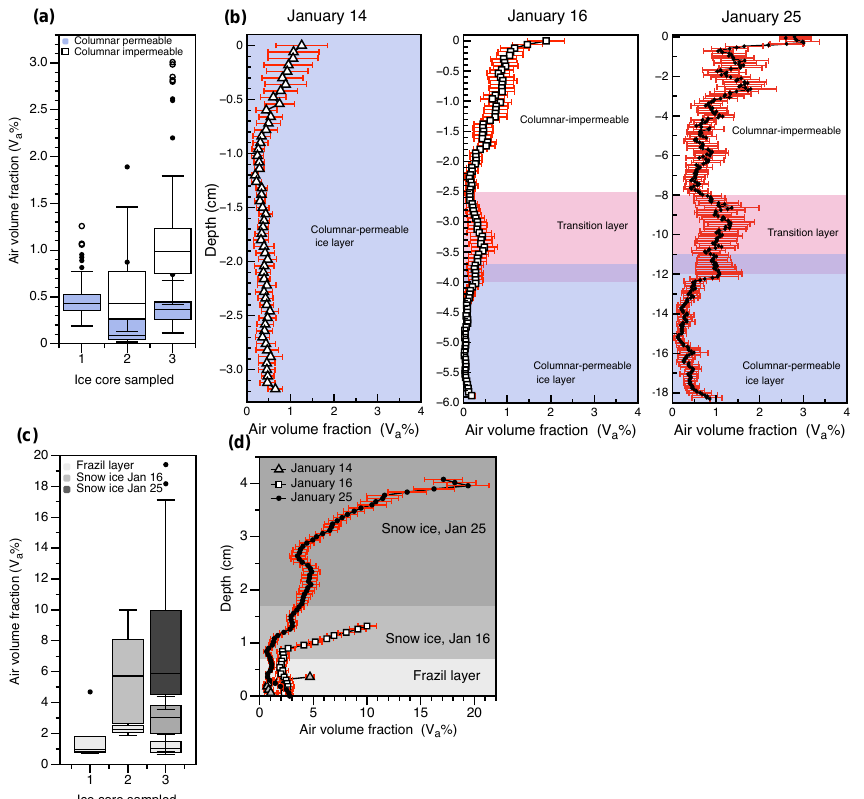
Figure 7. (a) IQR box plot showing the distribution of CT-derived V a computed for every 0.6mm thick slice of each ice core in the columnar impermeable and bottom columnar permeable layers on 14 January (1), 16 January (2) and 25 January (3), respectively. The box is defined by the first and third quartiles of the distribution, the line in the box is the median, the circles represent the outliers (an outlier is any value that lies more than one and a half times the length of the box from either end of the box, T bars). (b) V a profile in the columnar layers for 14, 16 and 25 January, respectively. The y scale differs for each date to obtain better visualization of the V a profile. The errors bars show the potential range of CT-derived V a in each transverse slice. (c) IQR box plot showing the distribution of CT-derived V a computed for every 0.6mm thick slice of each ice core in granular layers and (d) V a profile in granular ice for each sampling date.